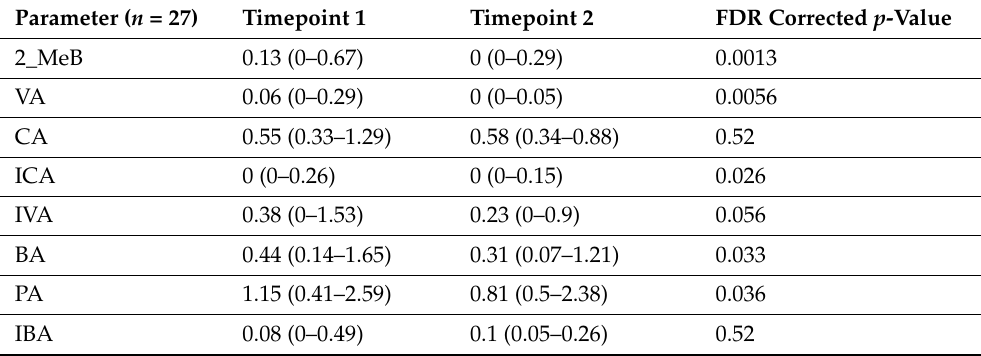
Table 2. The content of fatty acids in serum. Data obtained by the GC-MS